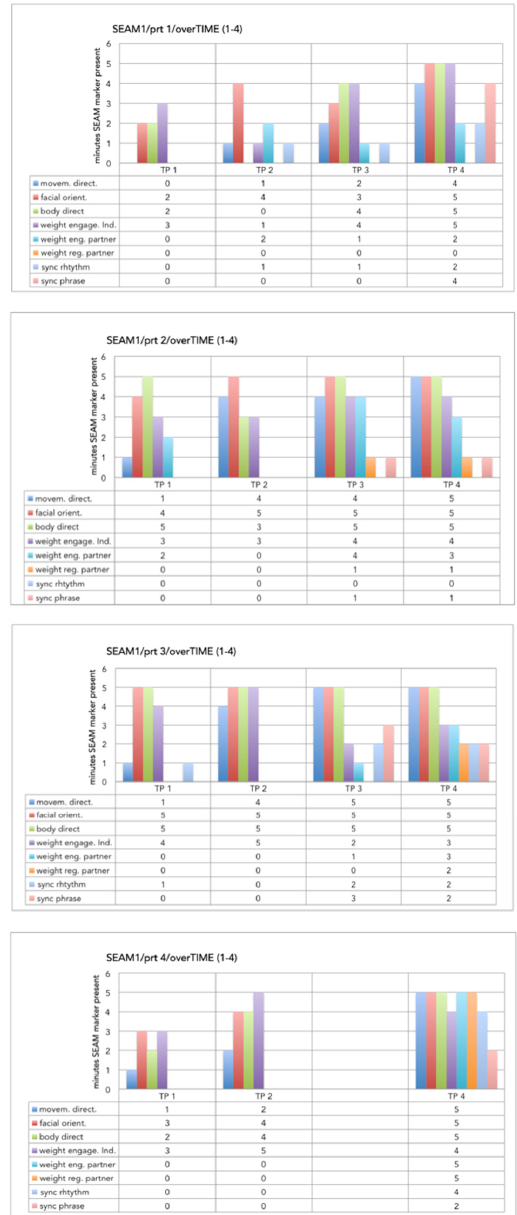
Figure A1. To Show a graphical summary of the individual profiles of SEAM scores at TP1, TP2, TP3,